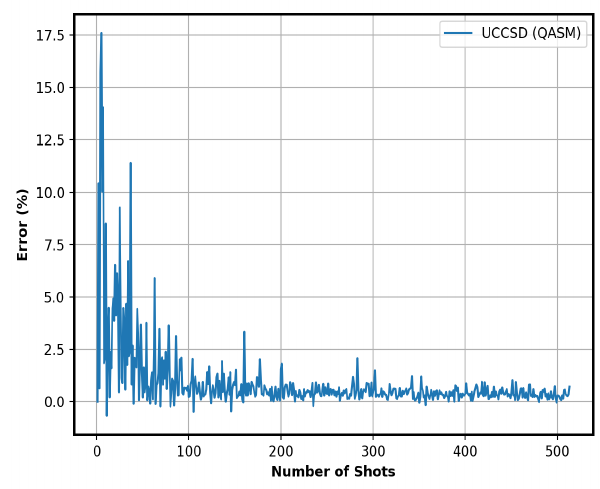
Figure 4. Plot showing the variation in the percentage fraction error in the calculated energy using the QASM simulator with respect to the Full Configuration Interaction value, with the number of shots up to 512, for Be in the STO-3G basis and with the Jordan–Wigner